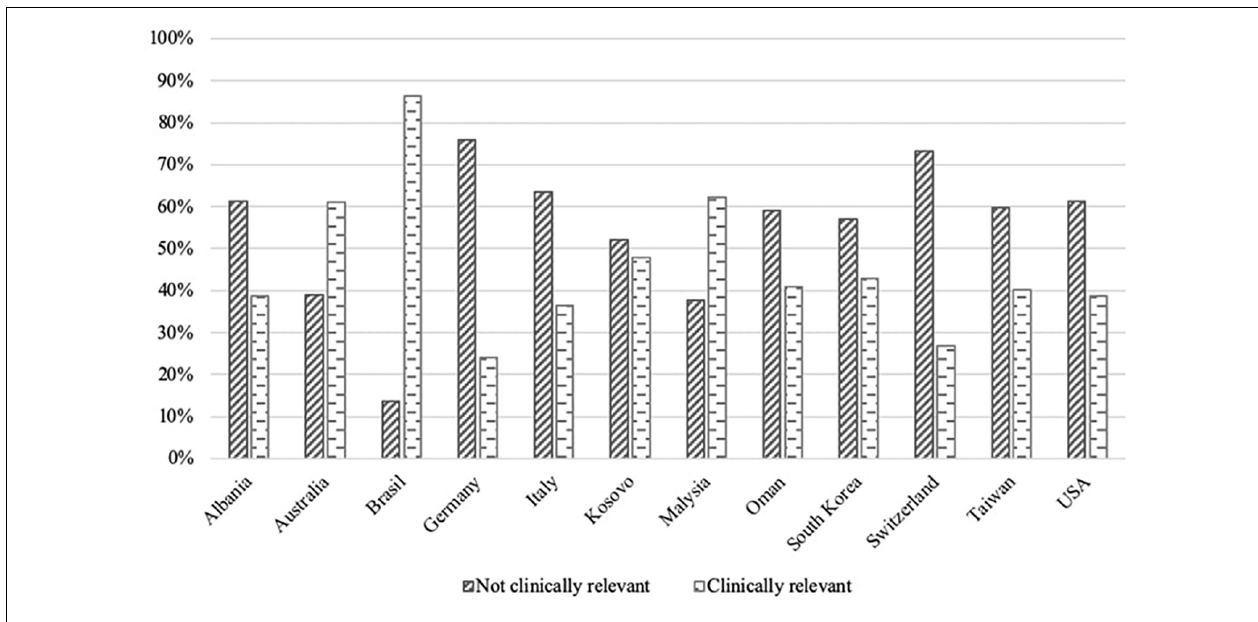
FIGURE 1 | Prevalence of depressive symptoms by